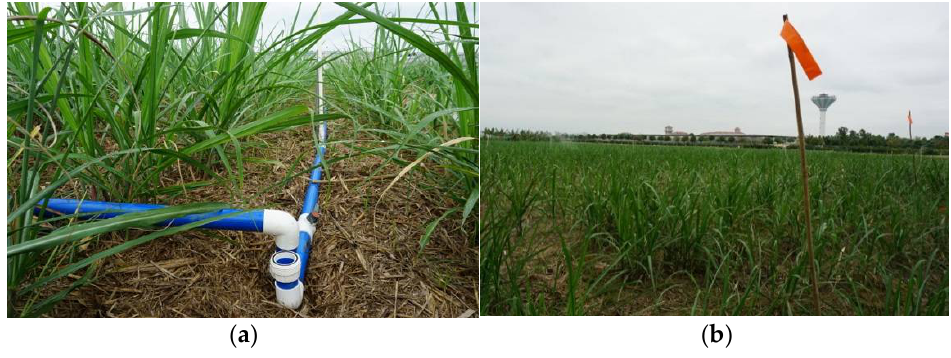
Figure 4. ( a ) CHL arm with rotating elbows and shutoff valve and ( b ) flags placed in the farm.